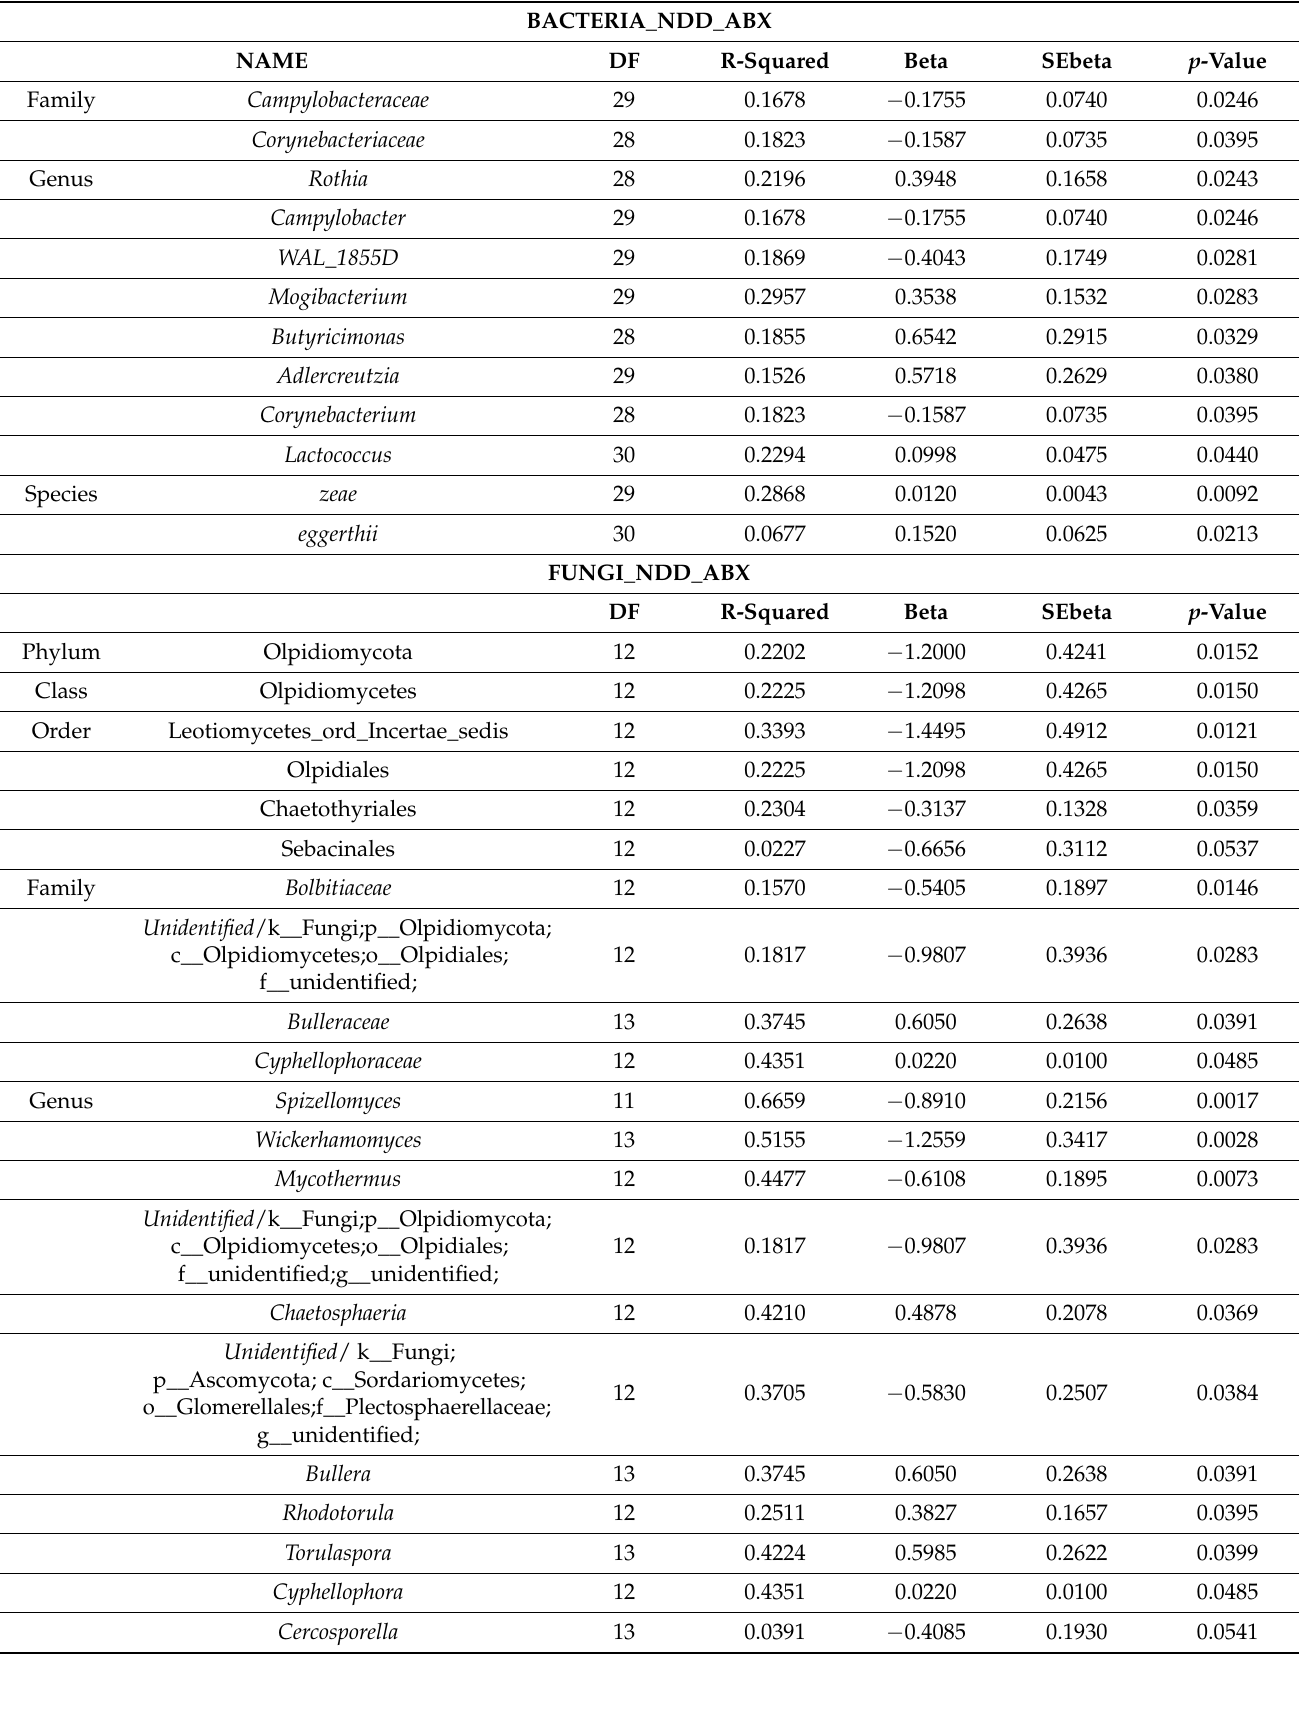
Table 11. Significant changes in bacterial and fungal absolute abundance with ABX exposure in